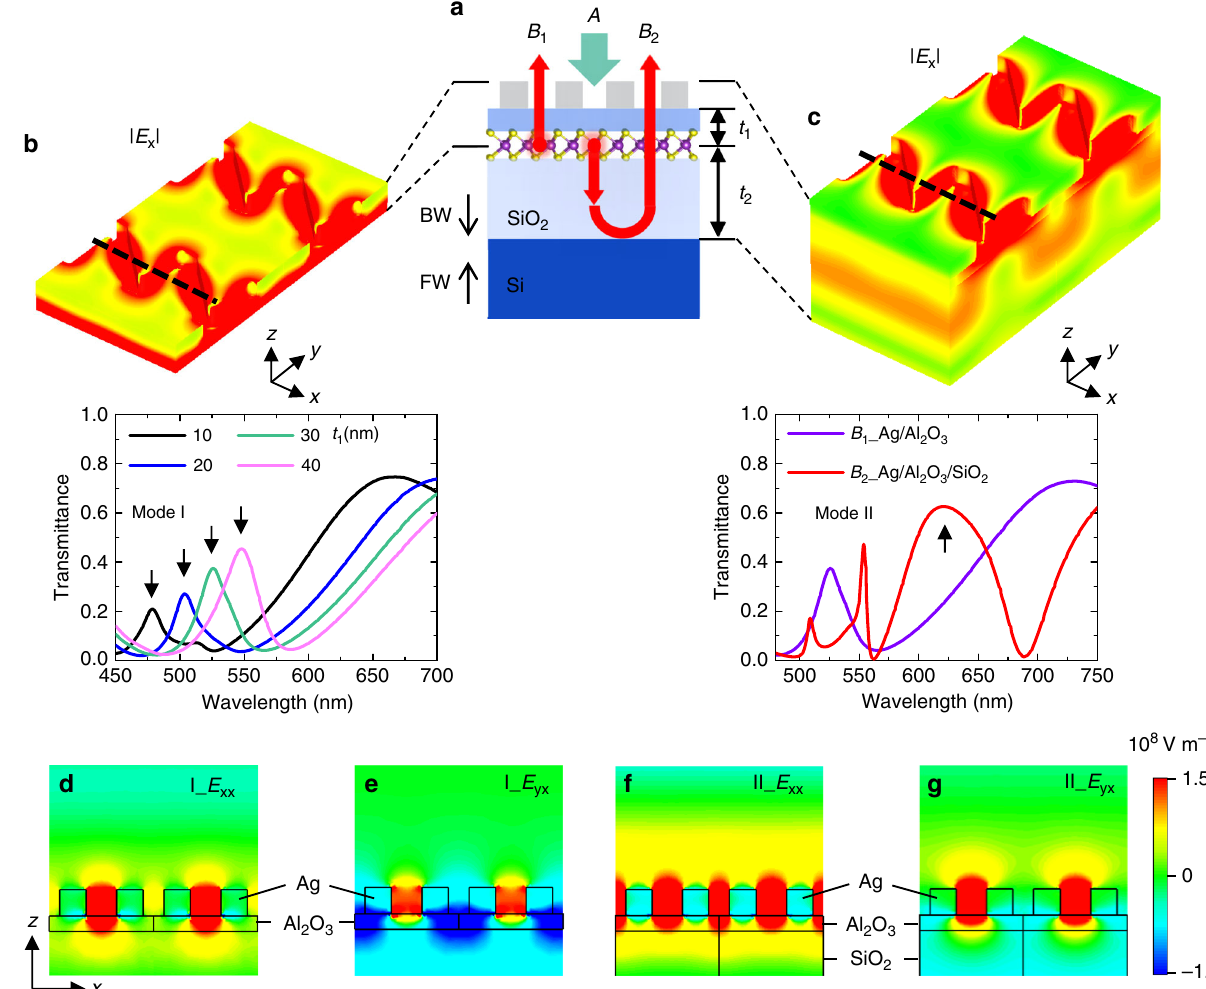
Fig. 2 Two optical modes dominating excitation and emission paths of the WS 2 -Ag hybrid nanostructure. a The excitation path of 532 nm pump laser from nanoslits to WS 2 in the backward (BW) direction is denoted as A , the emission path from WS 2 to nanoslits in the forward (FW) direction as B 1 and the emission path from WS 2 to Si and bounced back to the nanoslits as B 2 . t 1 and t 2 indicate the thickness of Al 2 O 3 and SiO 2 , respectively. b The BW transmittance spectra are simulated under the TE polarized light incidence for the excitation path A , i.e. silver nanoslits ( b = 200 nm, θ = 45°) on Al 2 O 3 with increasing t 1 from 10 to 40 nm, in which the resonance mode is denoted as Mode I whose electric fi eld distribution is presented in 3D. c The FW transmittance spectra of the emission paths B 1 and B 2 , i.e. silver nanoslits and Al 2 O 3 ( t 1 = 30 nm) without (violet curve) and with (red curve) SiO 2 , respectively, are calculated for the TE polarized light incidence, the latter of which exhibits a resonance mode II whose electric fi eld distribution is also depicted in 3D. d – g Electric fi elds E xx and E yx for resonances I and II in the xz plane cutting along the dashed lines denoted in the 3D view ( b , c fi nite-difference time-domain algorithm (FDTD Solution, Lume- rical) for x and y polarization excitations along both forward and backward directions 46 .